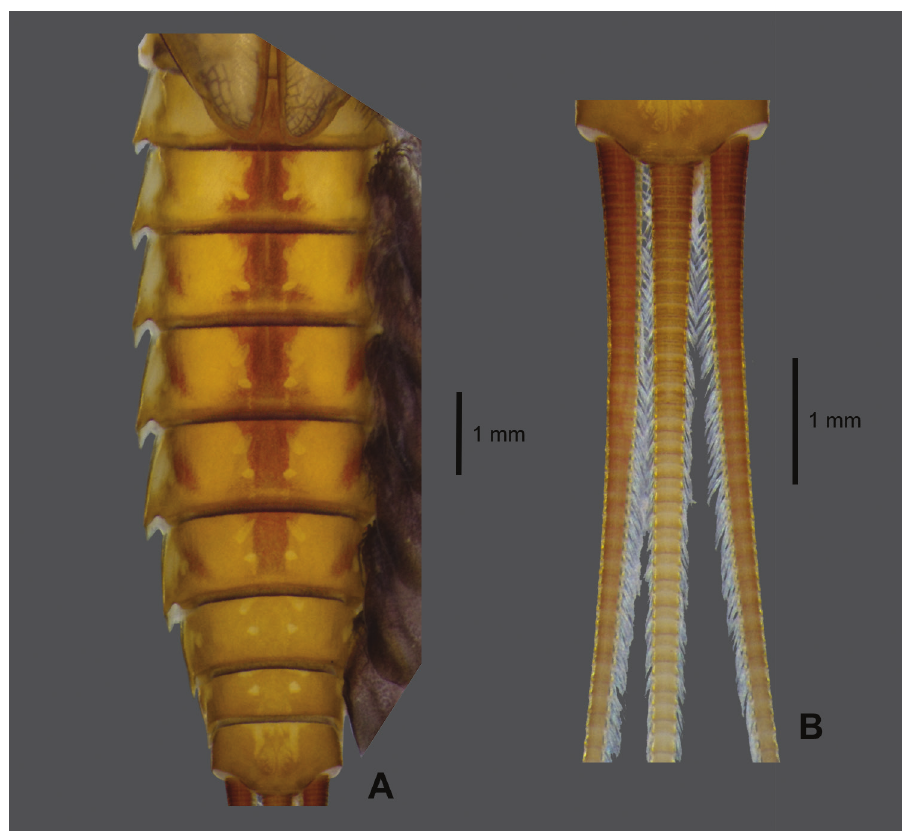
Figure 6. Paegniodes sapanensis sp. nov., larval morphology A terga II–X (dorsal view) B cerci and